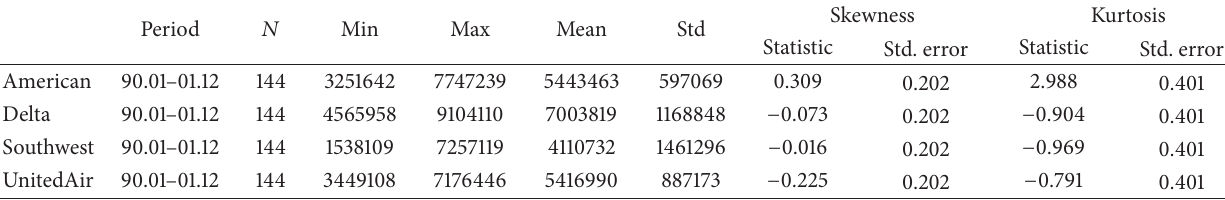
Table 1: Descriptive statistics of all data